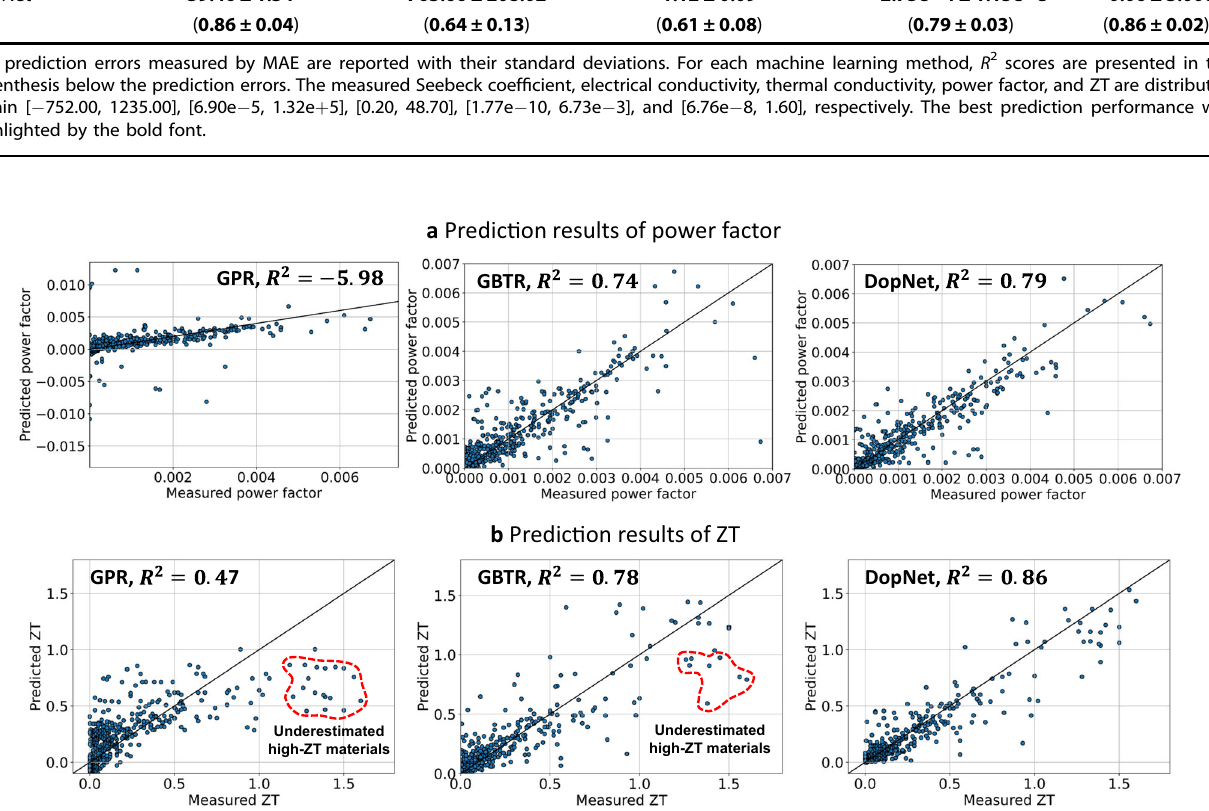
Fig. 3 Prediction results of the machine learning methods on the MRL dataset. a Scatter plots of the prediction results for the test materials in predicting power factor. b Scatter plots of the prediction results in predicting ZT. X and Y axes are measured and predicted materials properties,